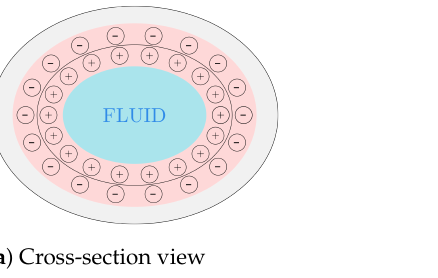
Figure 1. The electrical double layer (red highlighted area) and electroosmotic flow: ( a ) Cross-section view; ( b ) Along the channel length